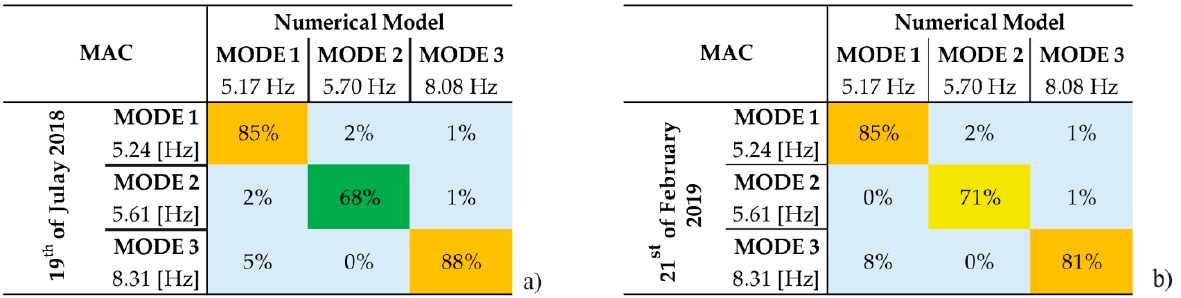
Figure 8. MAC -matrix between the updated FEM and experimental data collected on 19 July 2018 ( a ) and on 21 February 2019 ( b ).